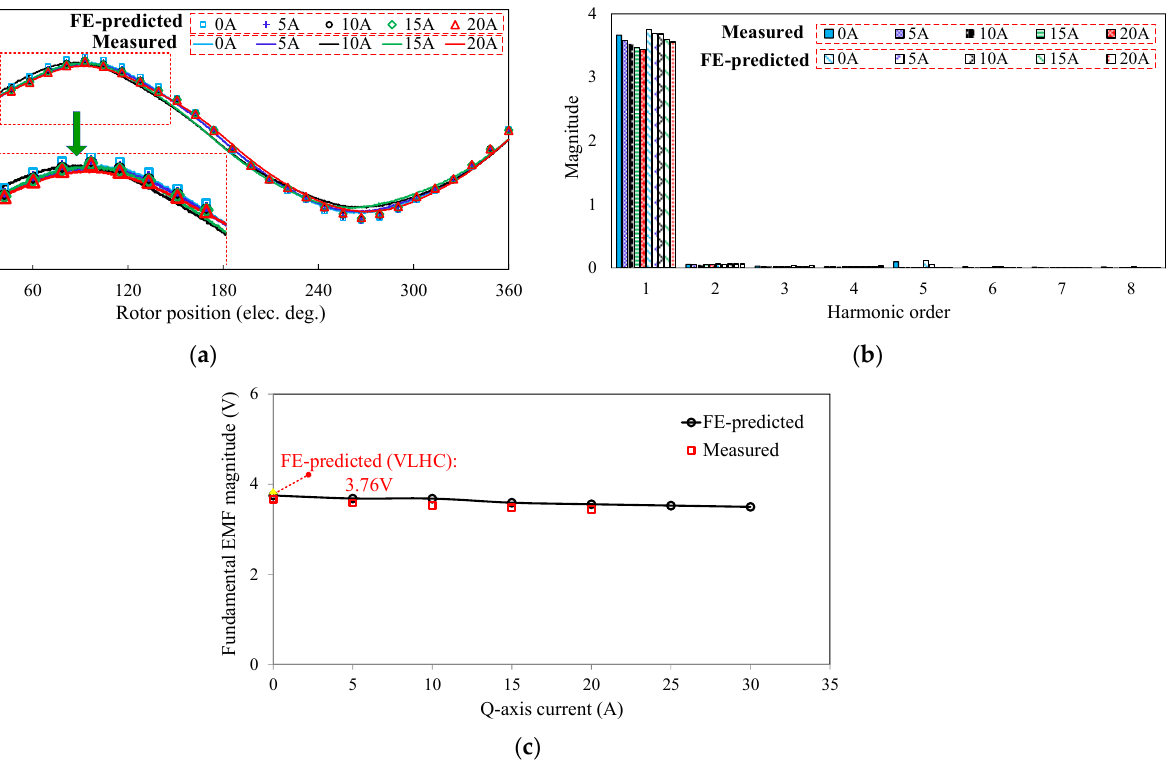
Rotor position (elec. deg.)